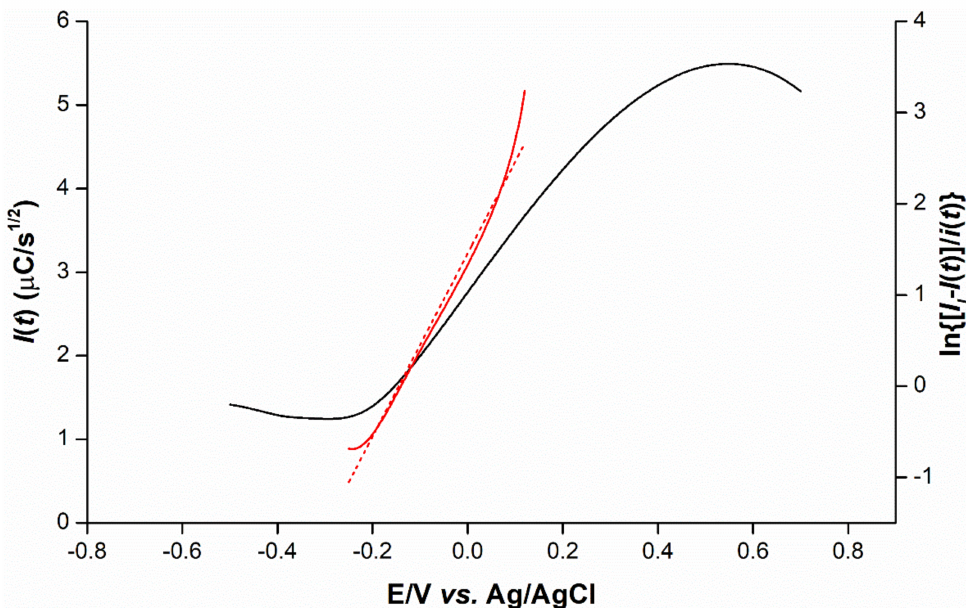
Figure 10. Semi-integral ( I ( t )) of a background-subtracted voltammogram (black line) and a plot of ln{[ I l – I ( t )]/ i ( t )} with potential ( E ) (red line). The short dashed line is the linear fit. The voltammogram derived from the DOS:TOTM hybrid sensor in 125 ppm cadmium(II) and 0.1 mM HCl solution at a scan rate 0.05